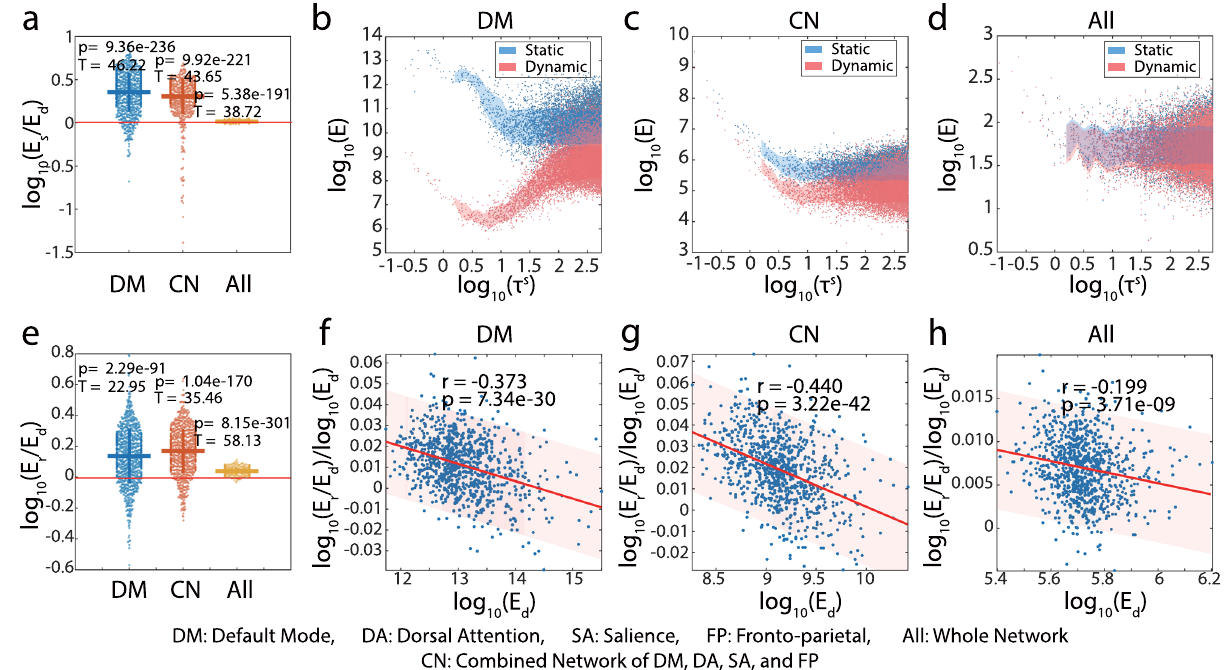
Fig. 3 Energy ef fi ciency explains the dynamic recon fi guration of functional connectivity. Each point in ( a – h ) represents a transition between a pair of initial and target states. The E s is the energy cost when the control dynamics are induced by the sFC-Correlation. The E d is the energy cost when the control dynamics is induced by the dFC-Slidingwindow. The E r is the energy cost when the control dynamics is induced by the same matrices of the dFC- Slidingwindow but in a randomly shuf fl ed order. The y-axis of ( f ) – ( h ) represents the log of the relative energy in fl ation when changing the connectivity matrices from the observed order to the random order. a We successively set Default Mode network (DM), the combination (CN) of Default Mode, Dorsal Attention (DA), Salience (SA), and Fronto-parietal networks (FP), or the whole network (All) as the control set. The T-tests measure their signi fi cance vs. zero. b When the network is controlled through DMN with varied control intervals ð τ Þ , the improvement of energetic cost (i.e., the vertical difference between blue and red dots) is higher on short control intervals (i.e., smaller τ ) than the long control intervals. Similar patterns exist when c the control set is the combination of DMN, DA, SA, and FP but with less signi fi cance. d The difference is less visually signi fi cant when controlling on the whole network. e When we permute the order of sequential matrices in the temporal control paradigm, we also observe an increase in the energy cost. f – h The relative increase of log energy is negatively correlated to the log energy corresponding to the observed order of recon fi guration for dynamic functional